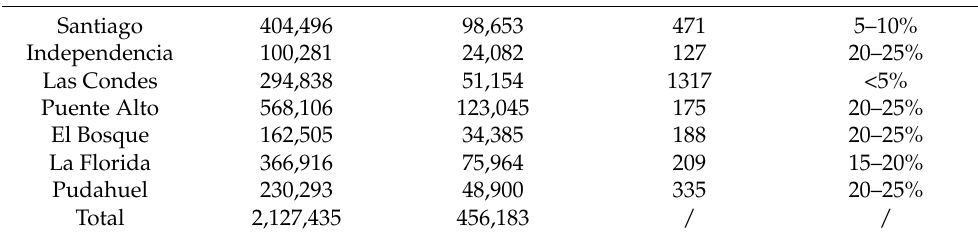
Table A1. Studied communes and population according to 2017 [27]. Each statement separated by a comma corresponds to a column of